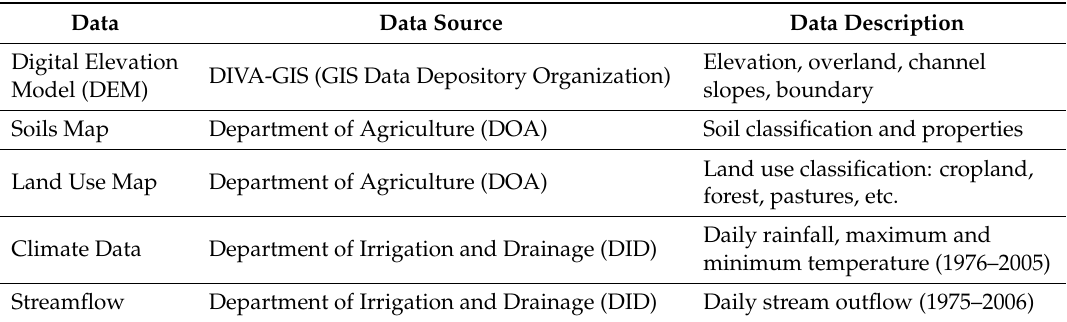
Table 1. Summary of the input dataset for flow modeling of Bernam River